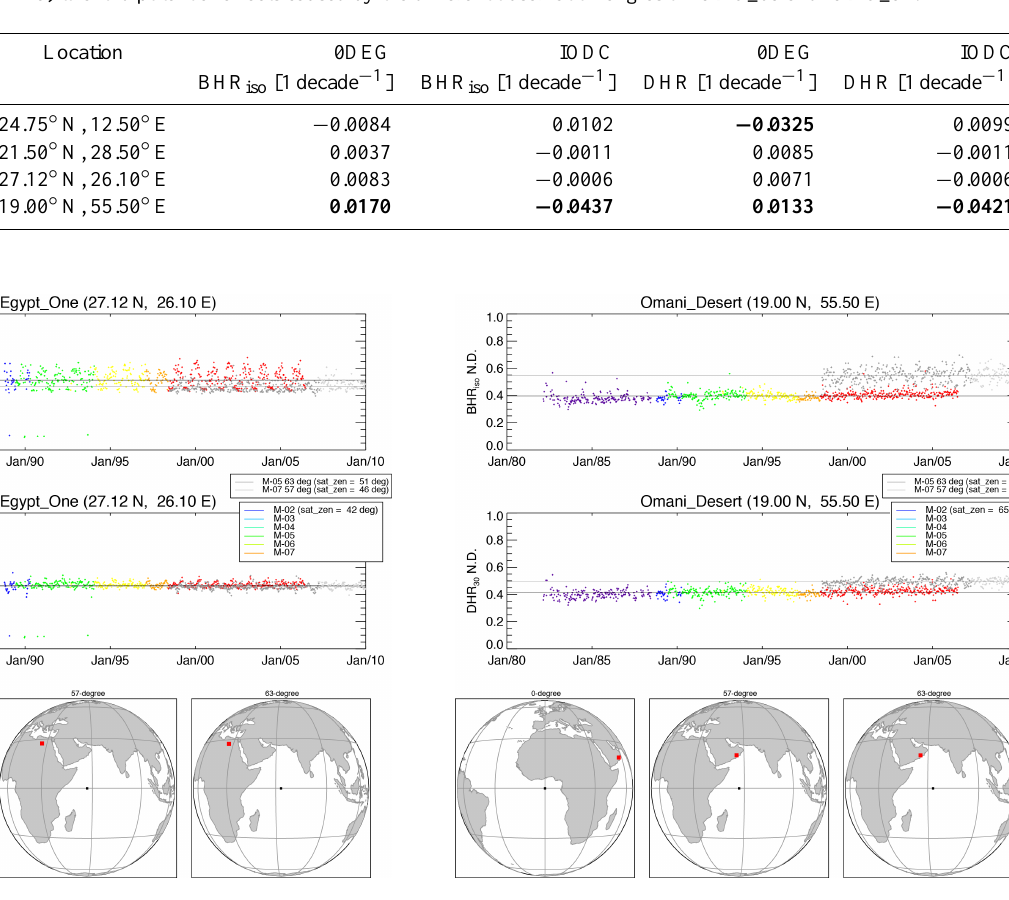
Table 3. Regression slopes for the four sites shown in Figs. 1–4. Values exceeding ± 0.01decade − 1 are in bold. IODC data are restricted to the 63 ◦ coverage (MVIRI-5) to avoid potential effects caused by the different observation angles of IODC_63 and IODC_57.